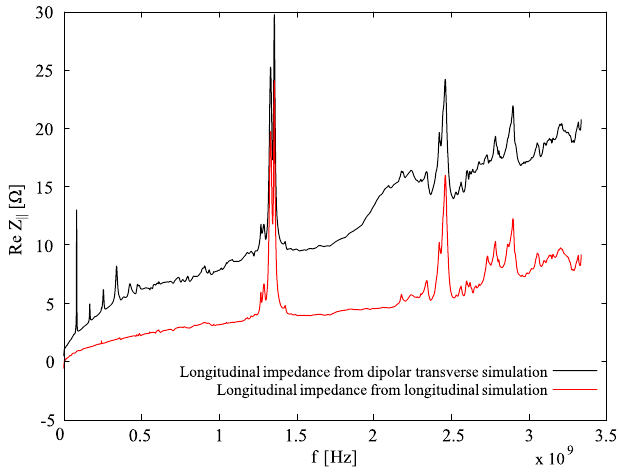
FIG. 5. Longitudinal impedances computed for a beam with zero transverse beam offset (red curve) and with a transverse beam offset as done in transverse dipolar impedance simulations (black curve). The computed low frequency HOMs correspond to transverse